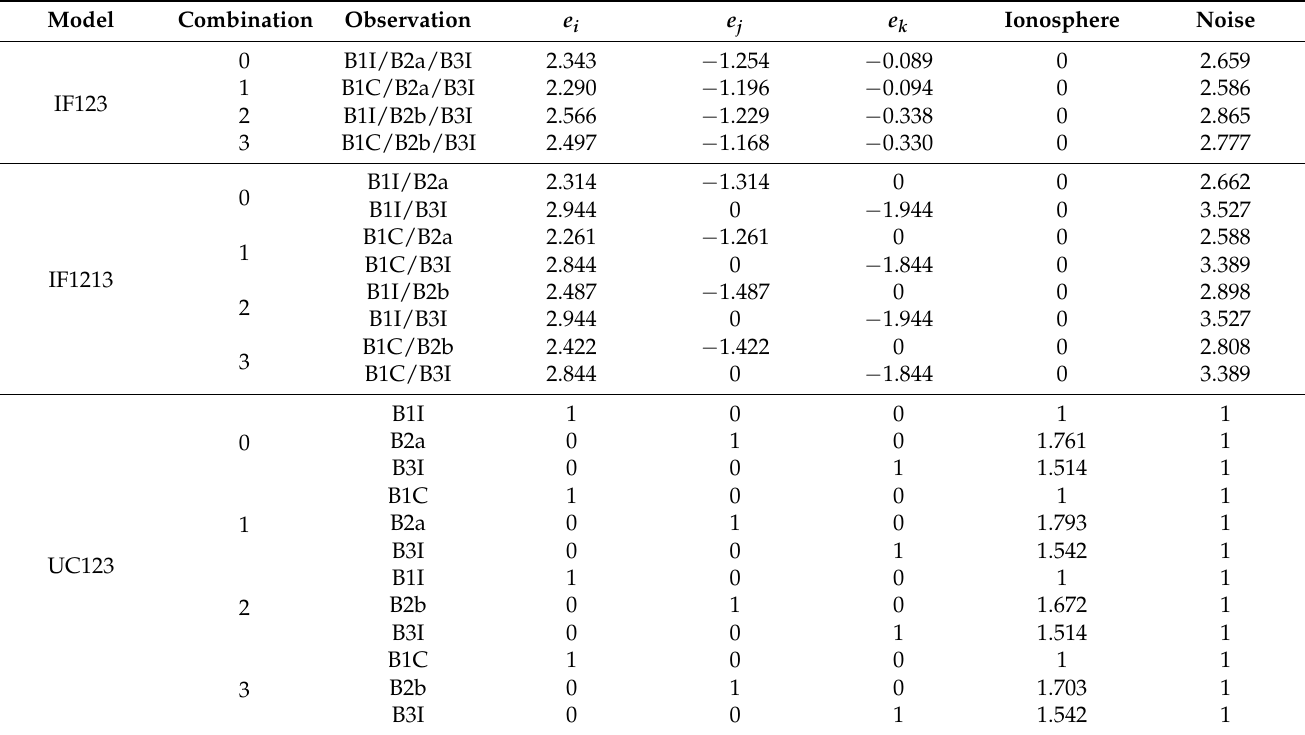
Table 1. BDS-3 triple-frequency model